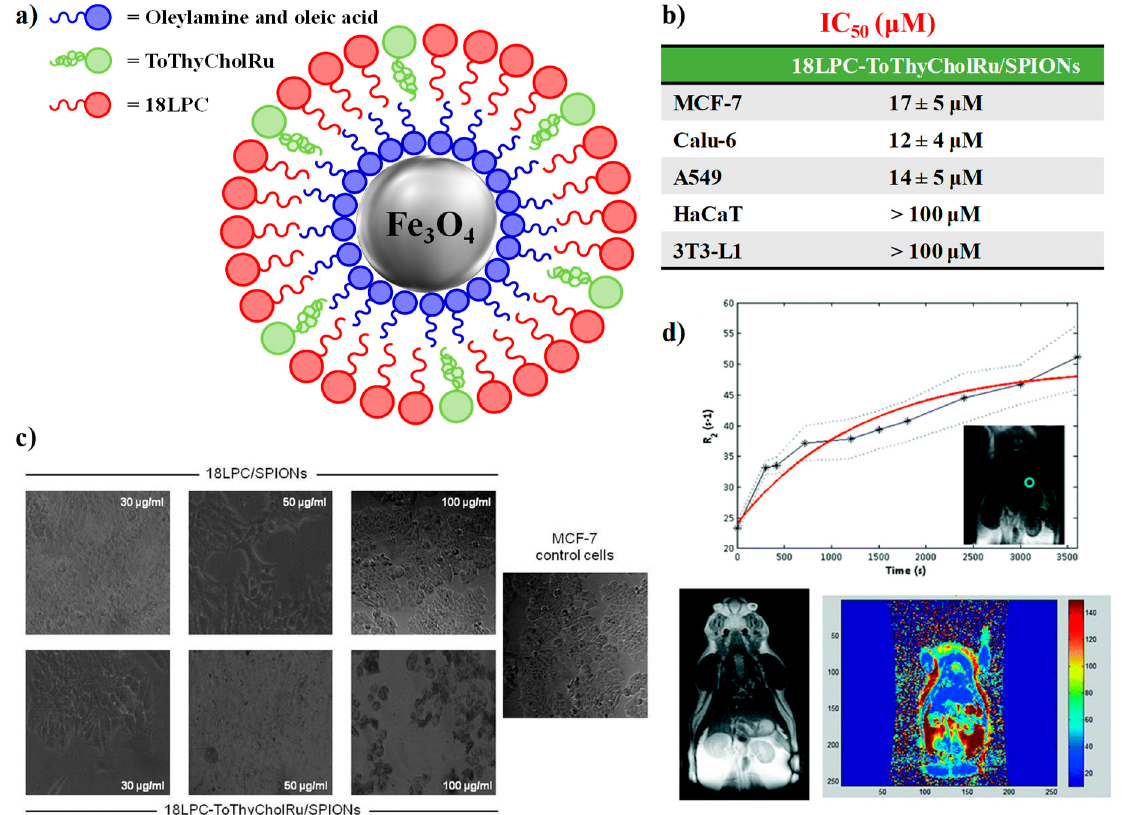
Figure 18. 18LPC-ToThyCholRu/SPIONs: schematic representation of NPs systems with the inner membrane layer based on oleylamine/oleic acid and the outer membrane layer composed of 18-LPC loaded with the Ru(III)-complex ToThyCholRu ( a ); IC 50 values (µM)—reported as mean ± SEM—relative to the effective ruthenium concentration carried by 18LPC-ToThyCholRu/SPIONs in the indicated cell lines following 48 h incubation ( b ); representative photomicrographs by phase-contrast light microscopy ( c ) of MCF-7 cell lines untreated (control cells, left) or treated for 48 h with the indicated iron concentration of 18LPC/SPIONs (top line) and of 18LPC-ToThyCholRu/SPIONs (bottom line); MRI measurements ( d ): transverse relaxation rate (R 2 = 1/T 2 , s − 1 ) measured after bolus injection in the tail vein of 18LPC/SPIONs in 0.9% NaCl solution (top) with inset representing the ROI, selected in the coronal plane covering the liver; T 2 -weighted image of a coronal view of the animal (Wistar rat) before injection of the 18LPC/SPIONs (bottom, left); representative T 2 -mapping MRI image of a coronal view after injection (t = 3 min) of the 18LPC/SPIONs (bottom, right). Figures are adapted from [108].